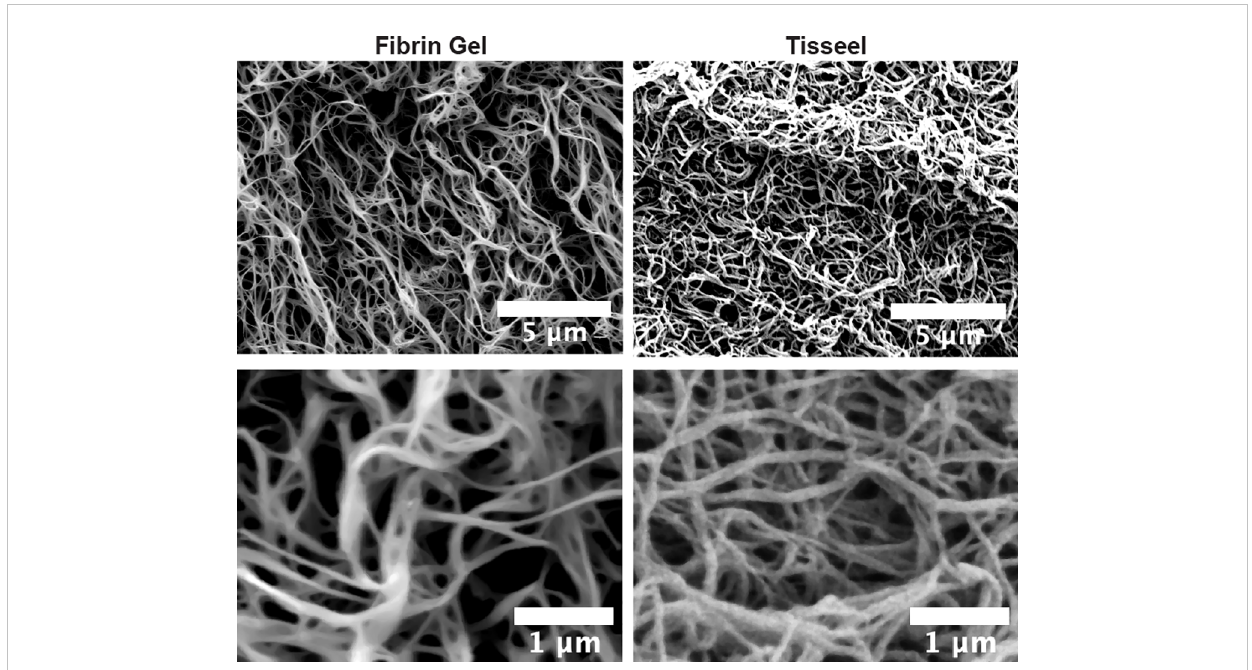
FIGURE 6 Microstructural differences between fi brin hydrogel and fi brin sealant Tisseel. Scanning electron microscopy (SEM) images of fi brin hydrogel (Fibrin Gel) and Tisseel at low and higher resolution. White bars represent scale indications (5 µm and 1